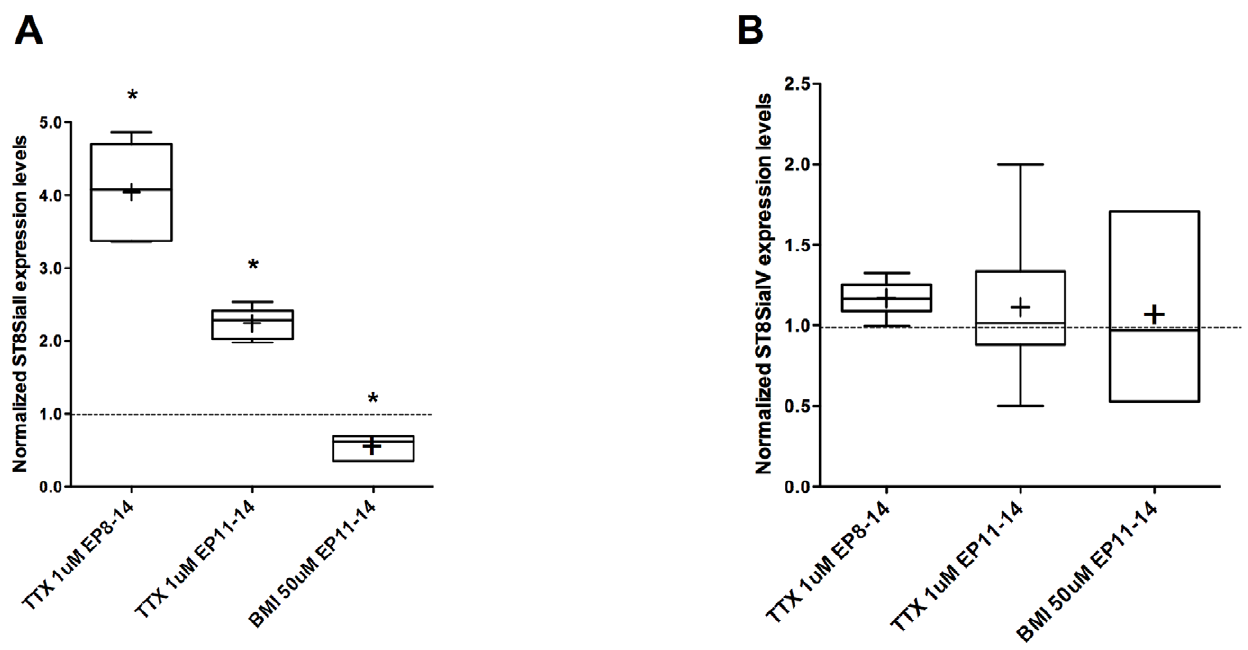
Figure 3. Spiking activity regulates ST8SiaII, but not ST8SiaIV, mRNA expression levels in cortical organotypic cultures. ST8SiaII (A) but not ST8SiaIV (B), developmental downregulation is impaired by TTX application (Two- Way ANOVA, Dunn’s test p , 0.05 for ST8SiaII in culture treated with TTX from EP8-14 and EP11-14; p . 0.05 for ST8SiaIV). Conversely, increasing spiking activity levels by BMI treatment accelerates ST8SiaII (A; Two-Way ANOVA, Dunn’s test p , 0.05), but not ST8SiaIV (B; p . 0.05) mRNA level downregulation. ST8SiaII and ST8SiaIV of each sample are first normalized to GAPDH levels, then to age-matched controls from the same litters and experiment. Graphs are plotted as explained in Figure 2.